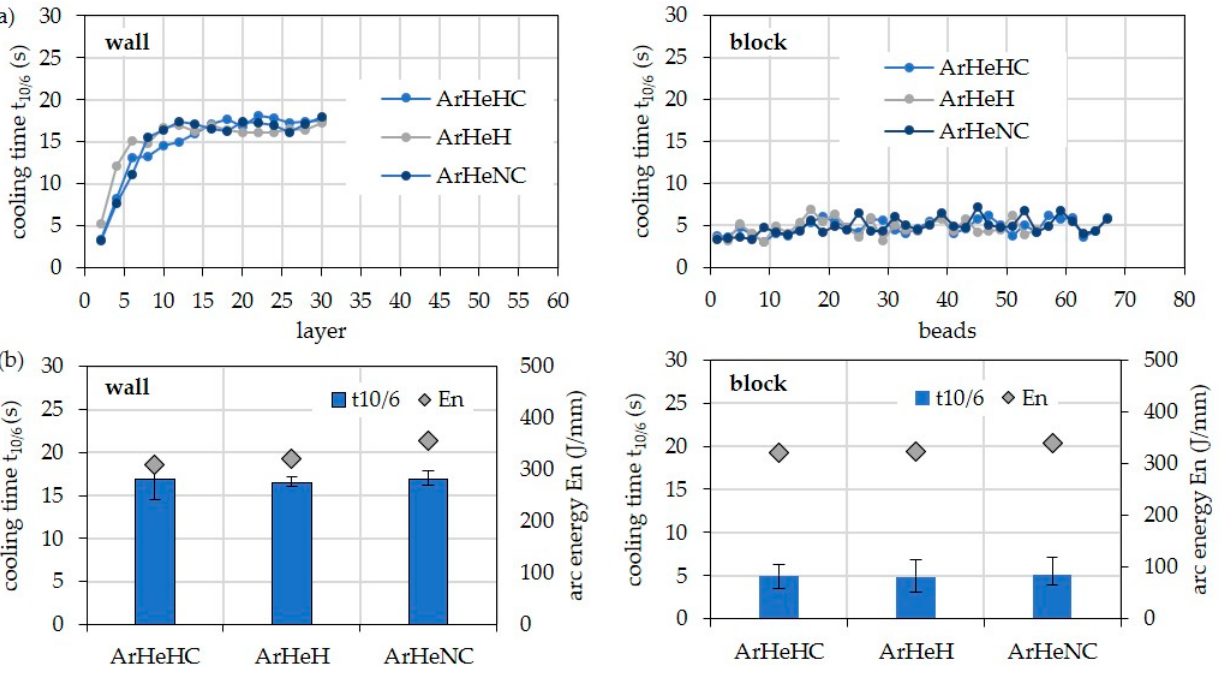
Figure 5. Cooling times of different parts (wall, block) welded with HY282 ( Φ 0.035 ″ ) depending on shielding gas. ( a ) Single values over the layers. ( b ) Arithmetic mean values from 10th layer.